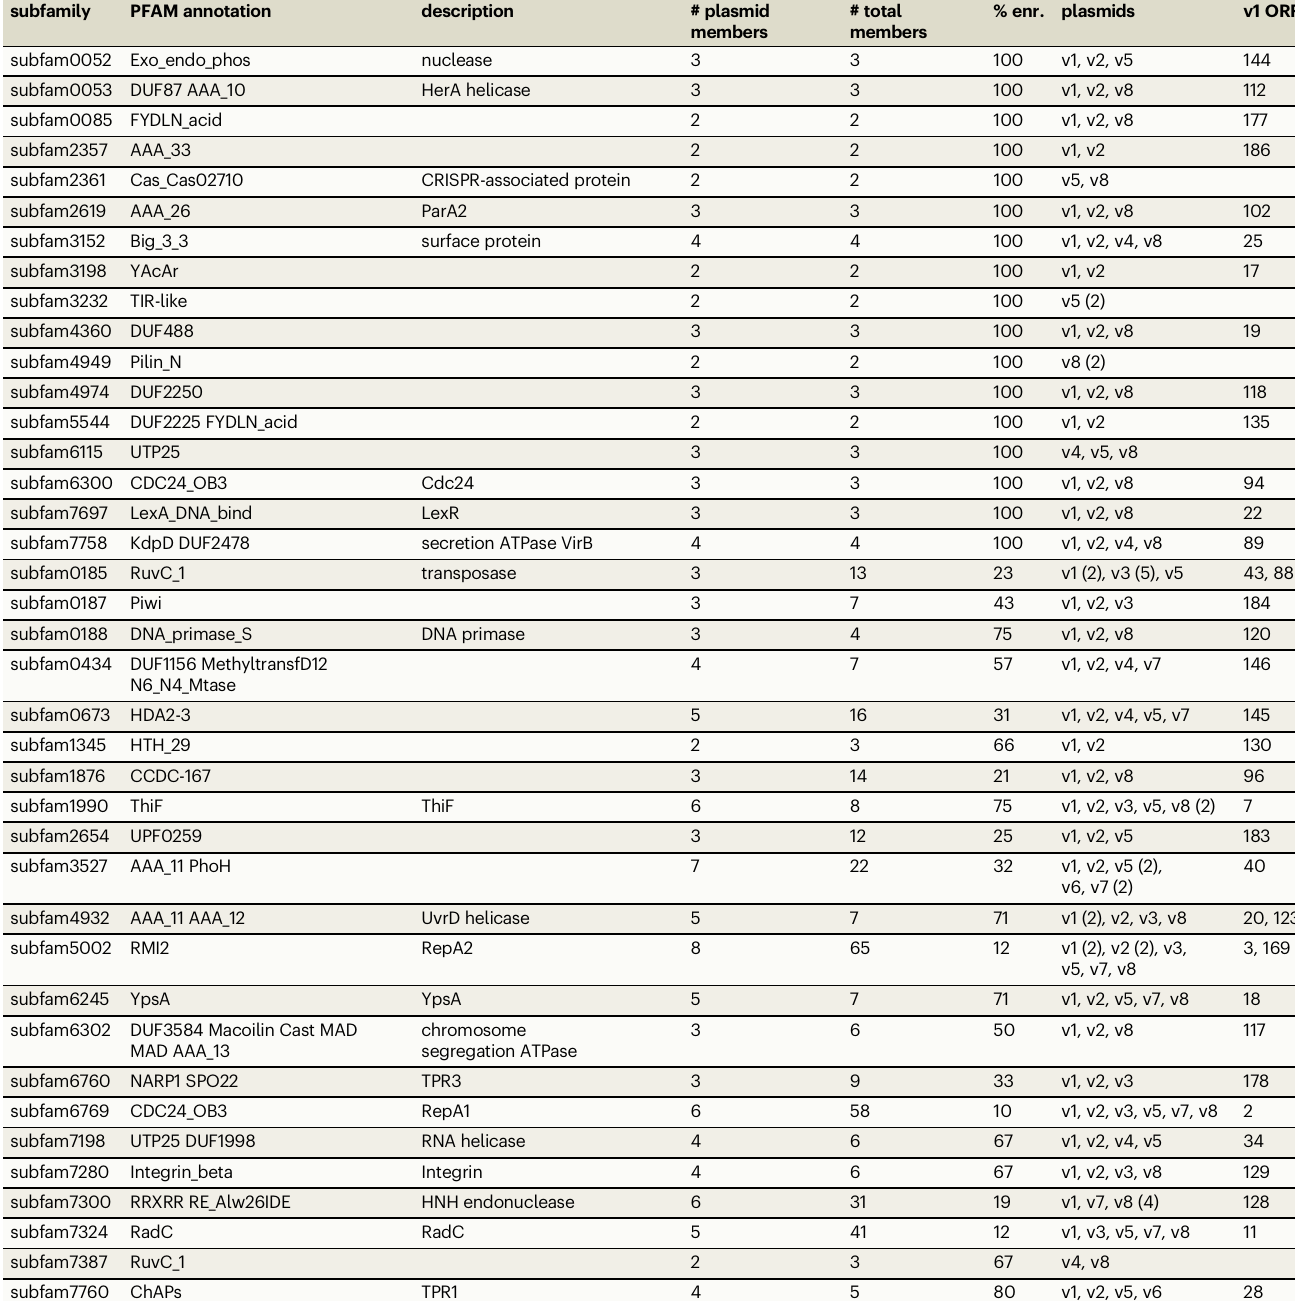
Table 2 | Proteinsubfamilies enriched in plasmid proteins. Numbers in brackets indicate the number of subfamily members per plasmid subfamily PFAM